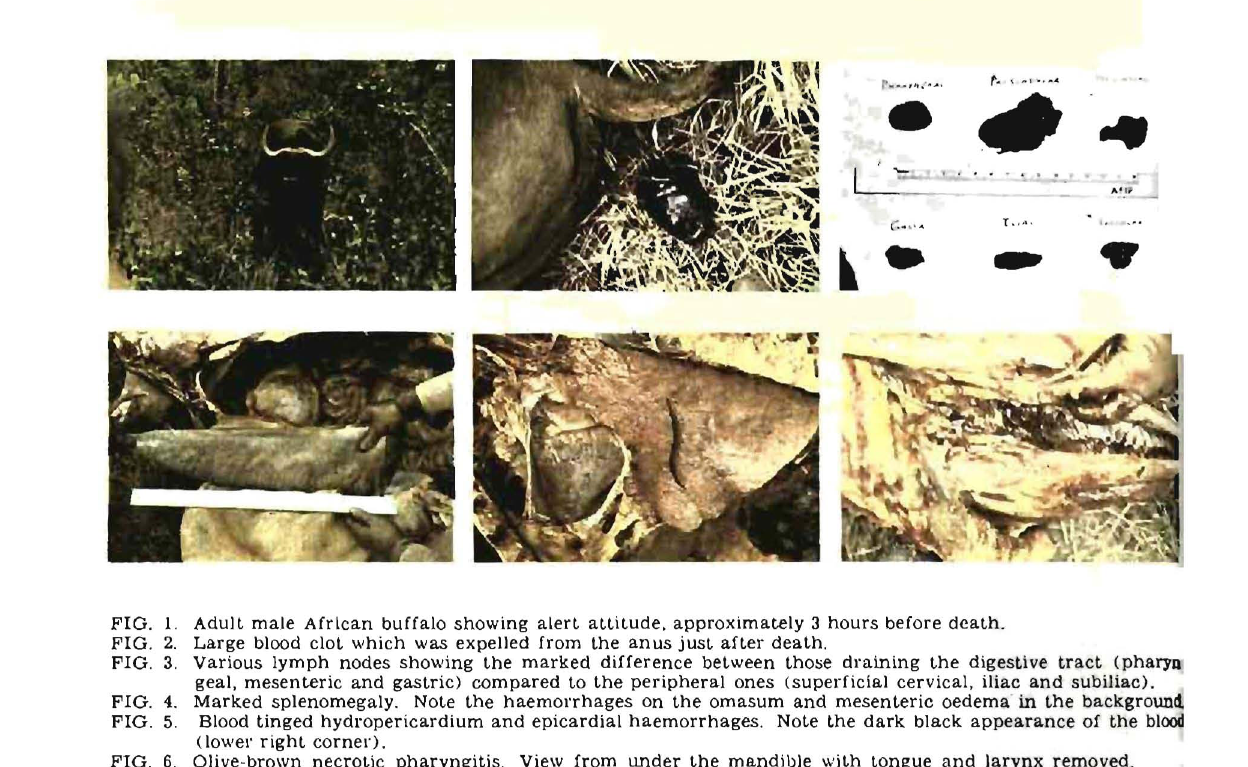
of the front feet. The coat was staring and the eyes were slightly sunken. During the next hour, some of these signs became pro gressively more pronounced and the buffalo once more charged at the truck. At 1025